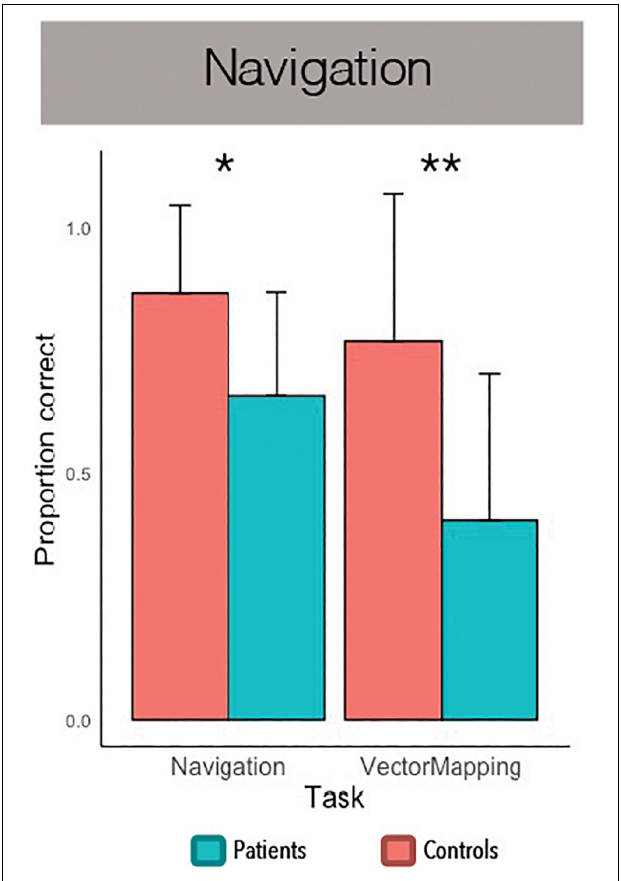
FIGURE 3 | Navigation task performance. * p < 0.05, ** p <